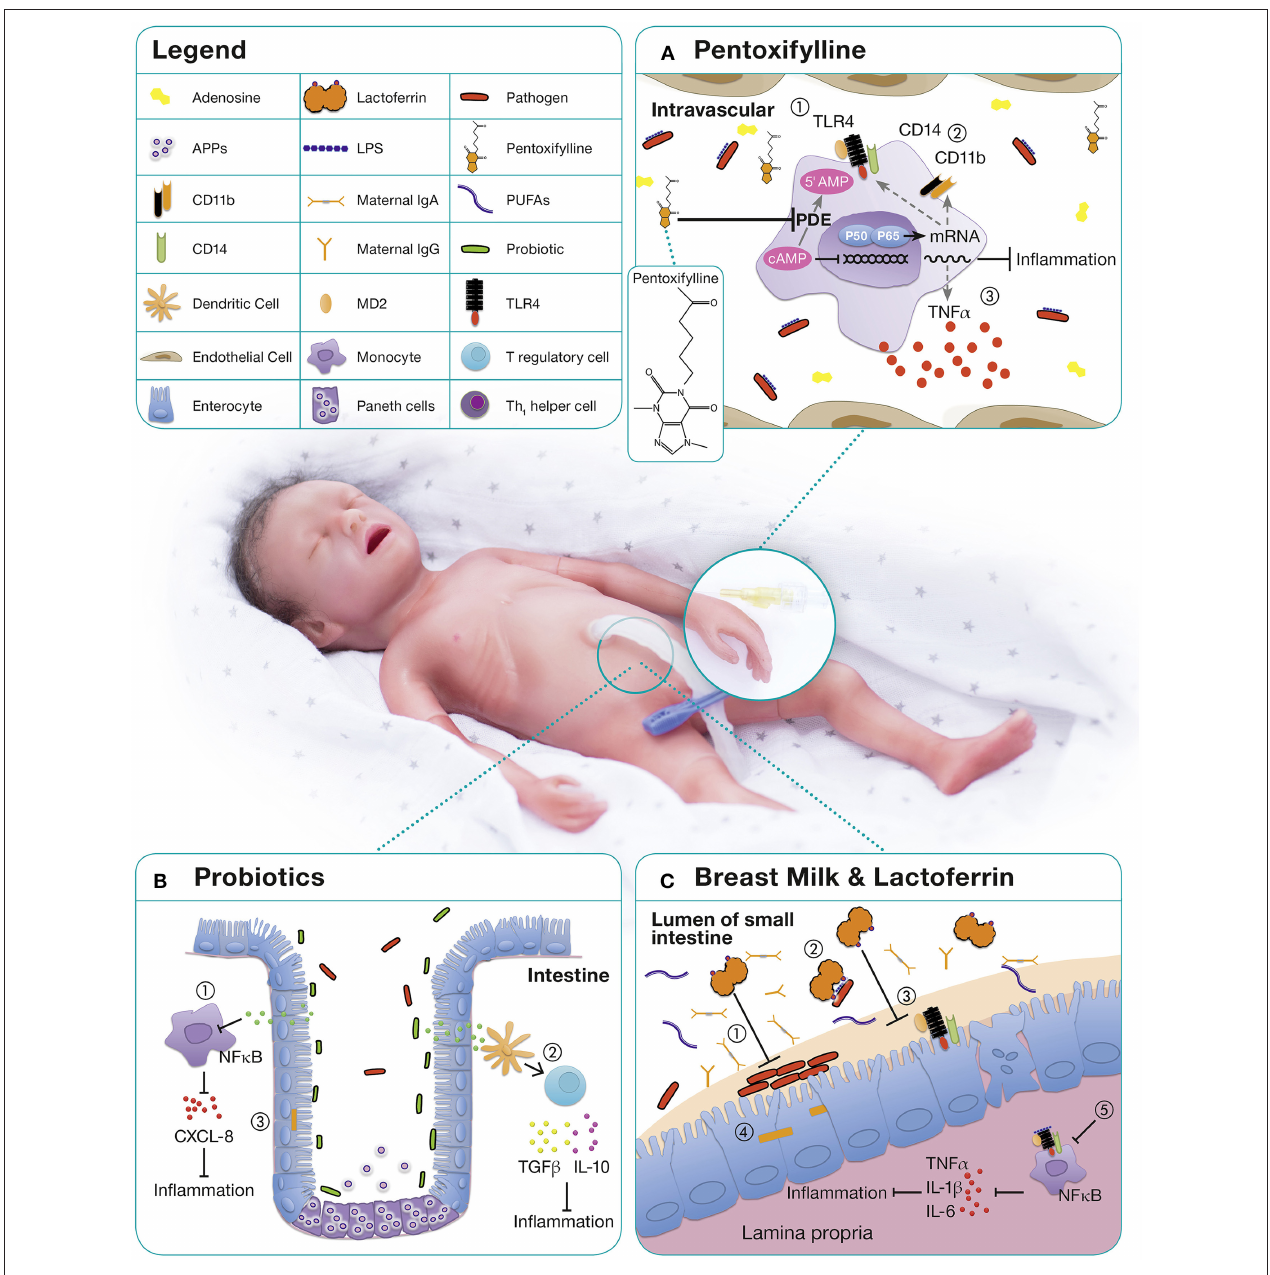
FIGURE 1 | Immunomodulatory approaches for the treatment and prevention of neonatal sepsis. (A) PTX, a phosphodiesterase inhibitor, mediates most of its functions by enhanced cyclic AMP (cAMP) due to a reduced degradation of cAMP (125, 126). Relatively high concentrations of adenosine are present in neonatal blood plasma and neonatal mononuclear cells demonstrate increased sensitivity to the cAMP-mediated inhibitory effects of adenosine (127, 128). As immunomodulatory properties of PTX are mediated via adenosine-dependent pathways, adenosine and PTX in combination, lead to a profound inhibitory effect on pro-inflammatory cytokine production (129). On neonatal APCs, PTX demonstrates anti-inflammatory properties by (1) down-regulating TLR4 expression and signaling, (2) downregulation of surface molecules such as CD14 and CD11b, and (3) inhibition of inflammatory cytokine production (70). (B) The microbiome of premature infants has a smaller proportion of beneficial bacteria and higher numbers of pathogenic bacteria compared to term infants, likely owing to higher frequencies of cesarean sections, antibiotic use, exposure to the hospital environment, and artificial feeding (130). The administration of probiotics up-regulates local and systemic immunity by (1) decreasing proinflammatory cytokines, (2) increasing the production of anti-inflammatory cytokines, and (3) decreasing the permeability of the gut to bacteria and toxins (131). (C) Human milk contains a range of distinct bioactive molecules that protect against infection and inflammation including immunoglobulins, long-chain PUFAs, and LF. Among them, the antimicrobial and immunomodulatory effects of lactoferrin are best studied: (1) Inhibition of bacterial adhesion and biofilm formation (132–134), (2) binding of endotoxins from intestinal pathogens (135), (3) blocking of receptors essential for epithelial invasion of microbes (136) thereby (4) prevention of bacterial translocation (137), (5) promotion of anergic/anti-inflammatory effects in LPS or LTA stimulated macrophages by TLR expression and pathway interference (138, 139).